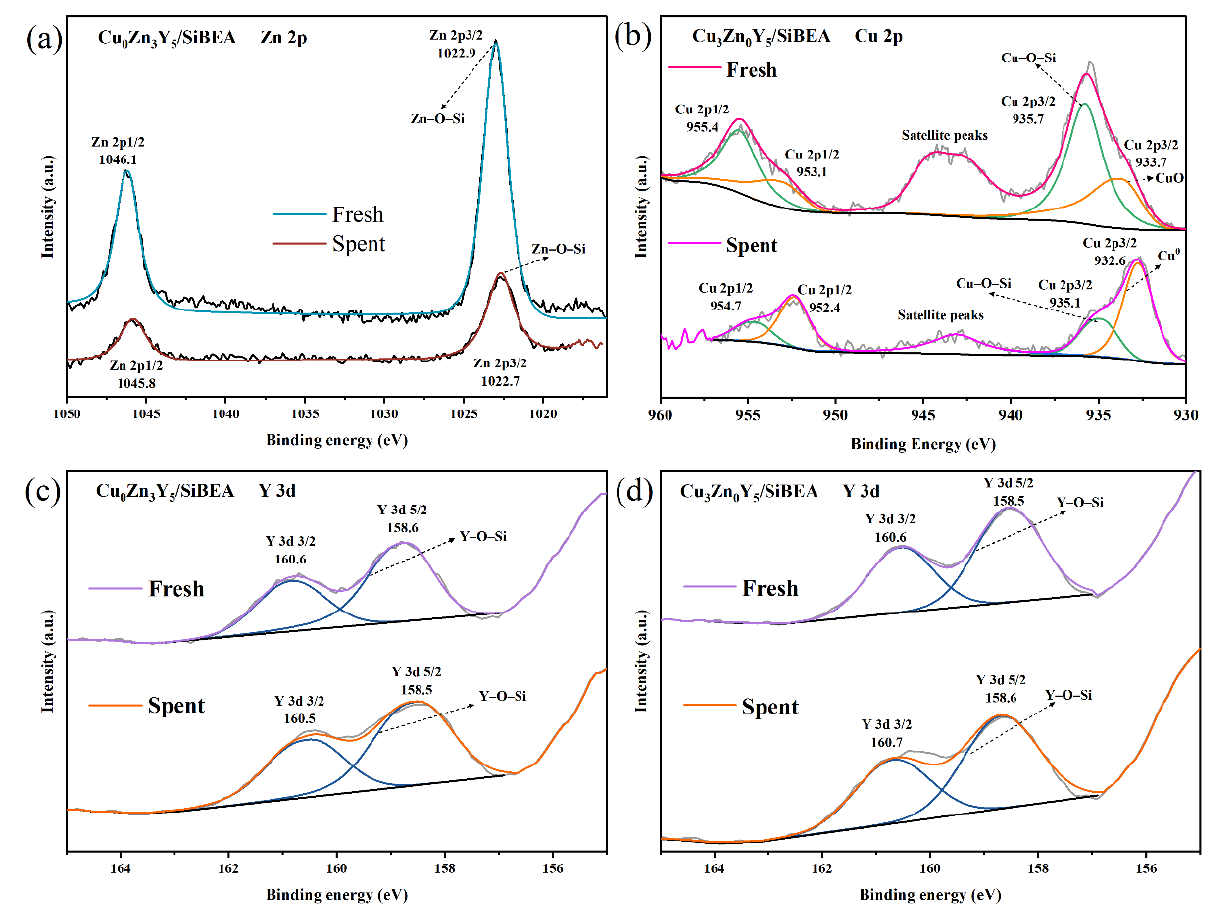
Figure 2. ( a ) Zn 2p and ( c ) Y 3d XPS spectra of fresh and spent Cu 0 Zn 3 Y 5 /SiBEA catalysts; ( b ) Cu 2p and ( d ) Y 3d XPS spectra of fresh and spent Cu 3 Zn 0 Y 5 /SiBEA catalysts.